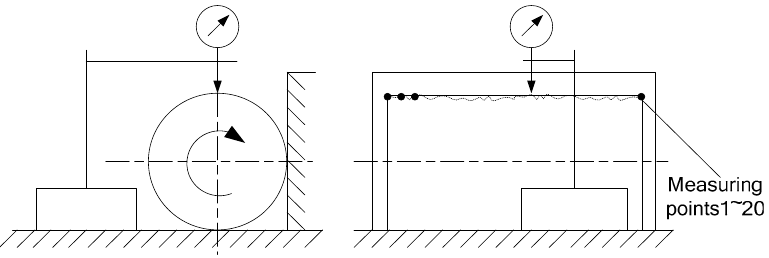
Figure 4. Measuring schematic diagram.